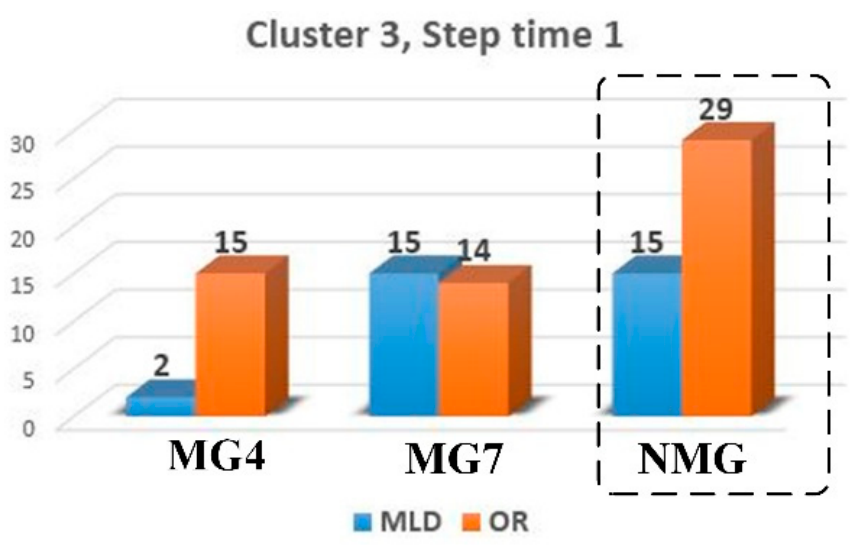
Figure 9. MLD and OR of MG4 and MG7 in individual and clustered operating mode.